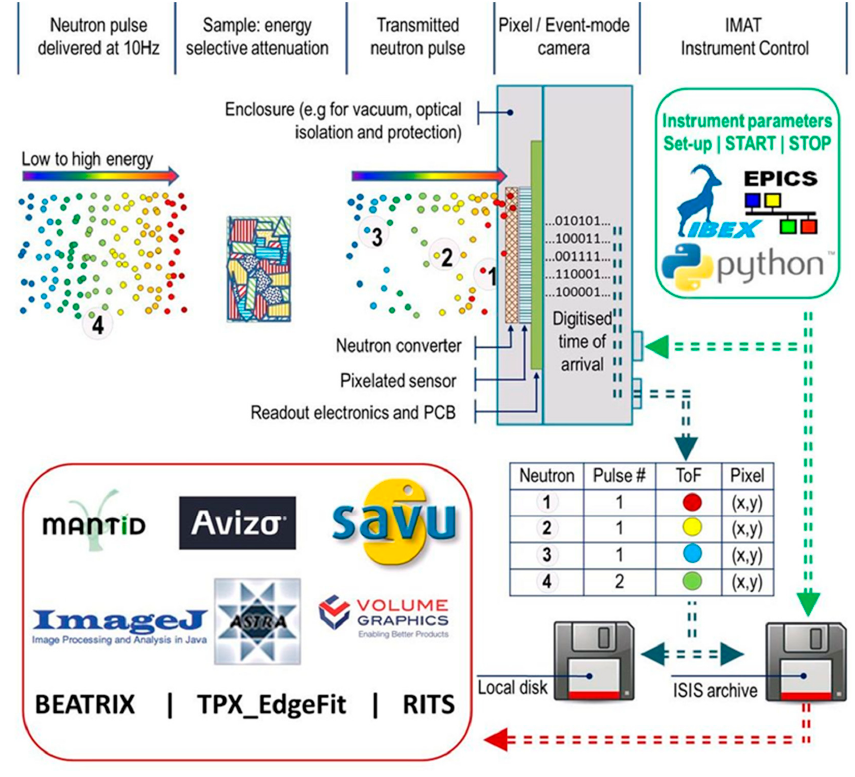
Figure 1. Time-of-flight (TOF) imaging schematic. The sketch illustrates the energy-dependent beam attenuation, as measured in a TOF imaging experiment. The TOF pixel detector records every neutron’s arrival time, with its (x,y) position. Four neutrons, labeled 1–4, from two separate neutron pulses are labelled to illustrate and emphasize this point. The camera is controlled via the IBEX GUI used on IMAT. For the image analysis a range of tools is available.